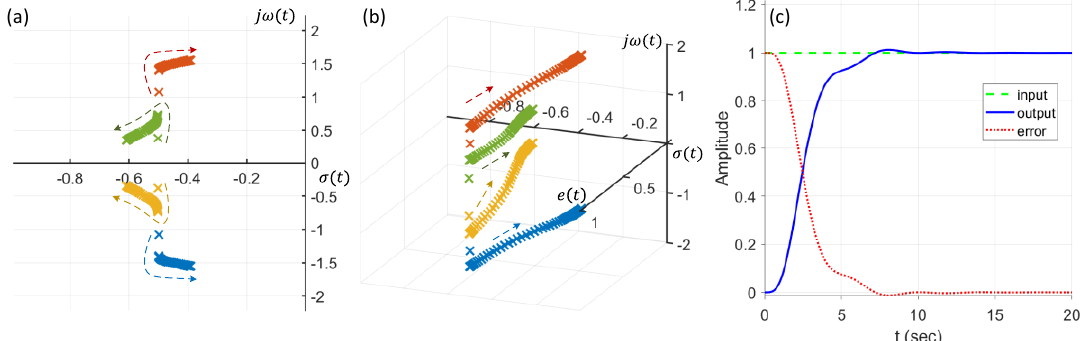
Figure 13. Dynamic pole motion of the controlled hybrid soft leg and the controlled system response by error change with the gains of K pf = 0.25, K vf = 0.5, α = 2, and β = 5: ( a ) 2D plot, ( b ) 3D plot, and ( c ) the system response to the step input. The arrows indicate the direction of pole motions.